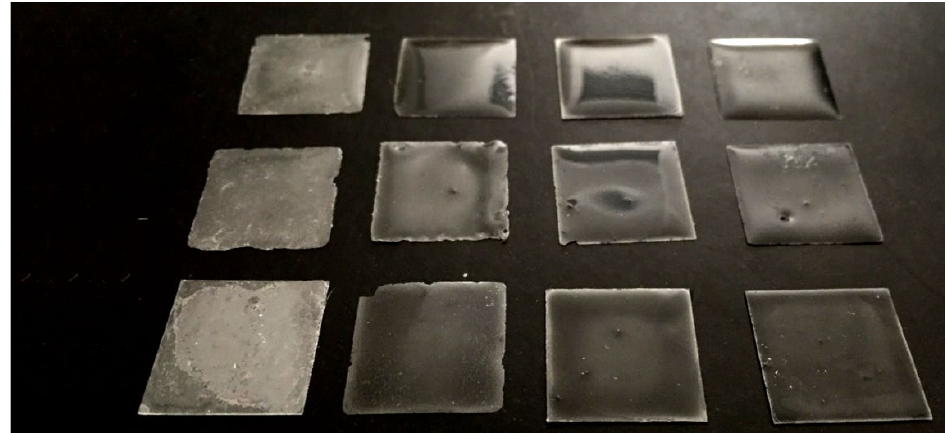
Figure 24. Overview image of all samples subjected to 31-day aging with an aqueous solution of Potassium Chloride, organized with respect to thickness and concentration of nanofiller.